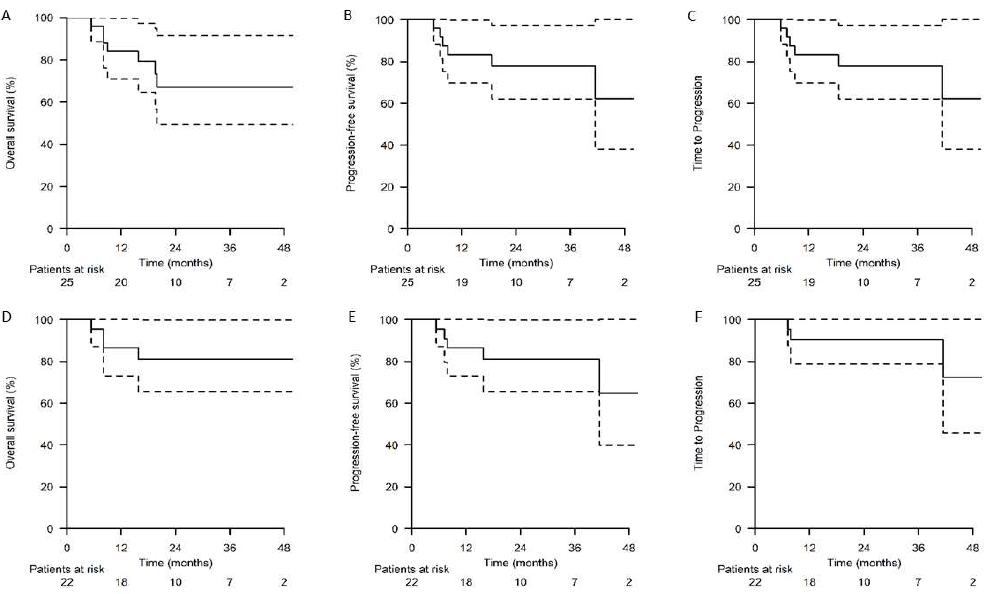
Figure 2. Survival outcomes. Overall survival, progression-free survival, and time-to-progression in the ( A – C ) ITT and ( D – F ) PPT populations.